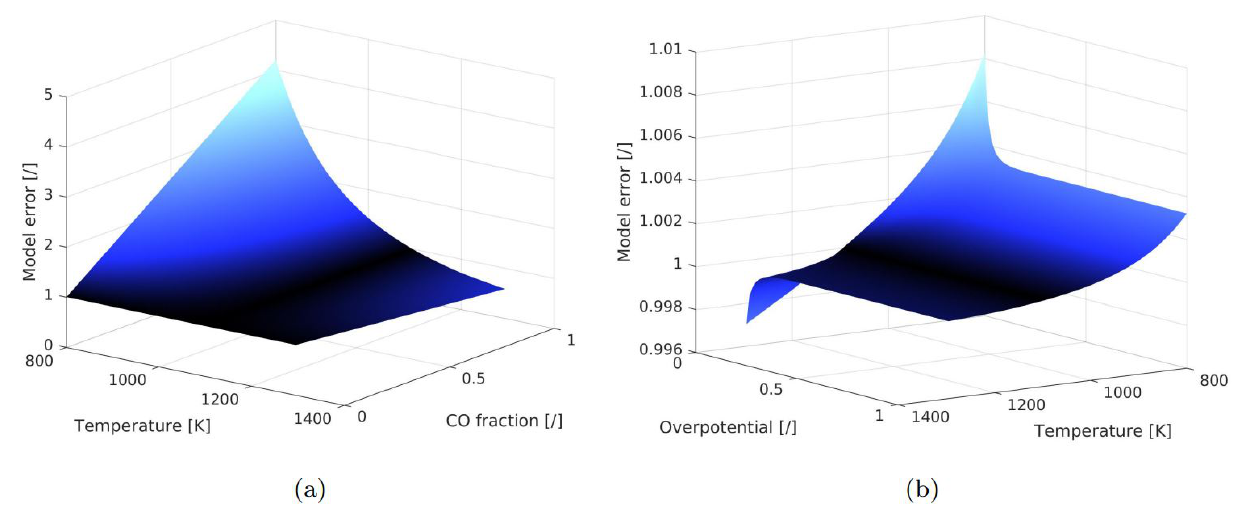
Figure A1. Estimation of the modelling error in comparison with the full blown solution presented in Equation (35) ( a ) in case of untypical and nonstandard operating conditions with the high molar ratio of CO in the fuel mixture at an over-potential level of 0.3 V and ( b ) in case of the molar ratio of CO being 1% of the fuel